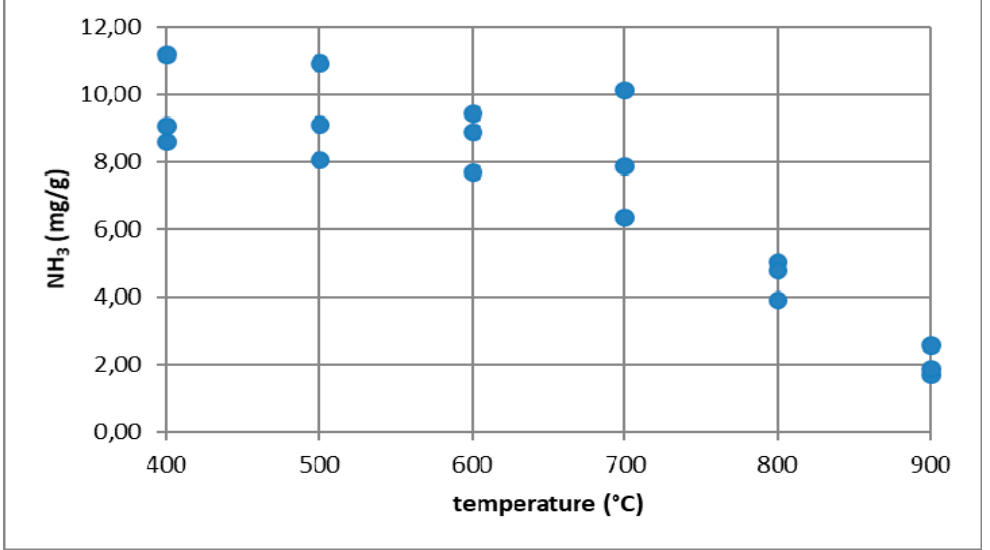
Figure 15. Mass percentage of PM2.5 components in particular seasons of 2010 in the monitoring station in Katowice [23].